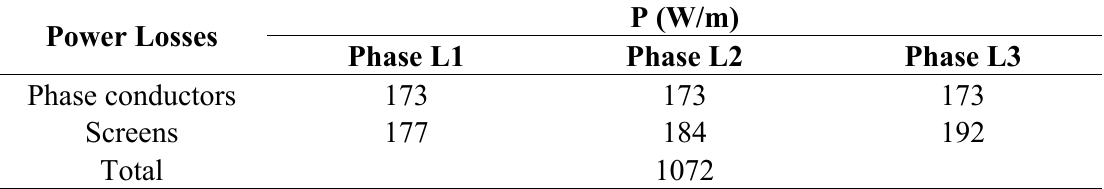
Table 2. Computed power losses of the high-current bus duct (screens grounded and mutually bonded on both ends and possibly additionally along the route).